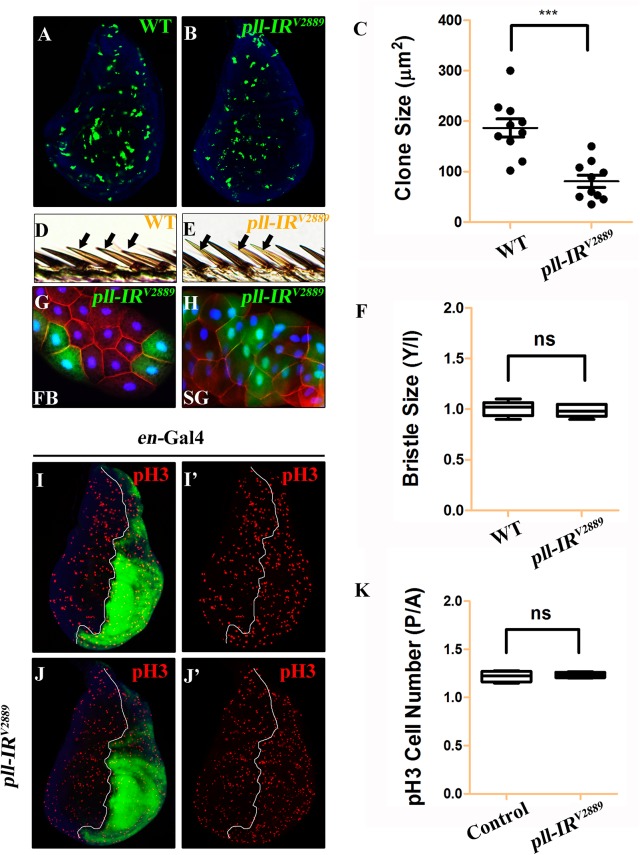

pll regulates cell number but not cell size in development.(A and B) Fluorescence micrographs of third instar larval wing discs with clones (marked by GFP) expressing no (A) or pll RNAi (B). Clones were induced by heat shock at 37°C for 1 hour and recovered at 25°C for 42 hours. Nuclei were labeled with DAPI (blue). (C) Quantification of clone size shown in A and B. Unpaired t test was used to calculate statistical significance, indicated with asterisks (*** P<0.001, n = 10 in each group). (D and E) Clones (marked by y-, yellow) expressing no (D) or pll RNAi (E) in adult wing margin bristles, 7 days after induction. (F) Quantification of bristle size as shown in D and E. The ratio of bristle size within clones (Y)/bristle size of internal control (I) remained unchanged when pll was knocked down in the clone. (G and H) Fluorescence micrographs of clones (marked by GFP) expressing pll RNAi in third instar larval fat body (FB, G) and salivary gland (SG, H) 42 hours after induction. Nuclei were labelled with DAPI (blue), cell membranes were stained by anti-Dlg antibody (red). (I and J) Fluorescence micrographs of wing discs are shown. The P compartment was labelled by GFP, while cell proliferation was detected by anti-pH3 staining (red) (I’ and J’), nuclei were labelled with DAPI (blue). (K) Quantification of pH3 positive cells shown in I and J. The P/A ratio of pH3 positive cells remained unchanged when pll was knocked down in the P compartment. ns stands for not significant. For all wing discs, anterior is to the left and dorsal up. Detailed genotypes: (A and D) y w hs-Flp/+; act>y+>Gal4 UAS-GFP/+ (B, E, G, H) y w hs-Flp/+; act>y+>Gal4 UAS-GFP/UAS-pll-IR
V2889 (I) en-Gal4 UAS-GFP/+ (J) en-Gal4 UAS-GFP/UAS-pll-IR
V2889.